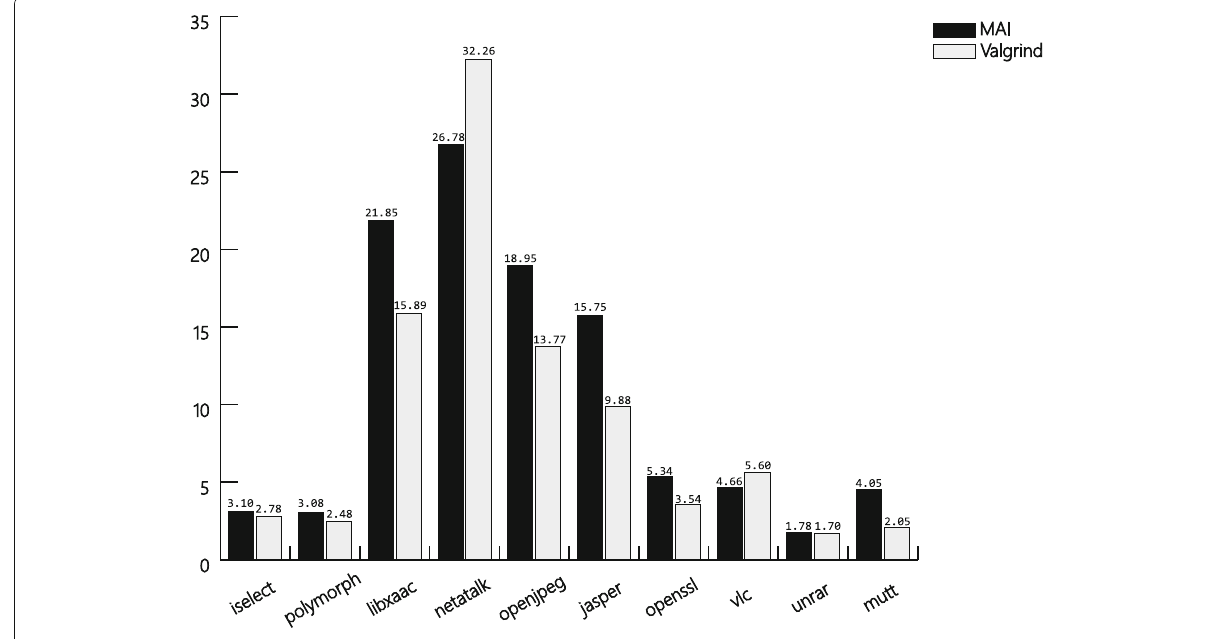
Fig. 18 MAI and Valgrind overhead for 10 real programs